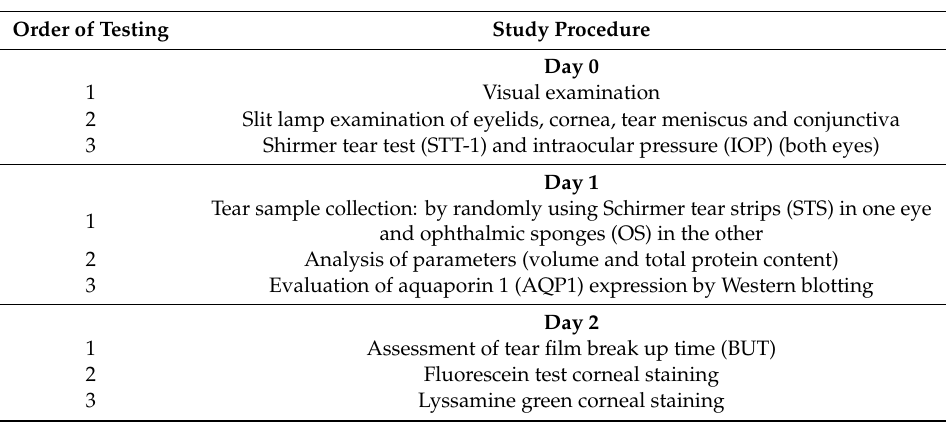
Table 2. Study procedures and order of